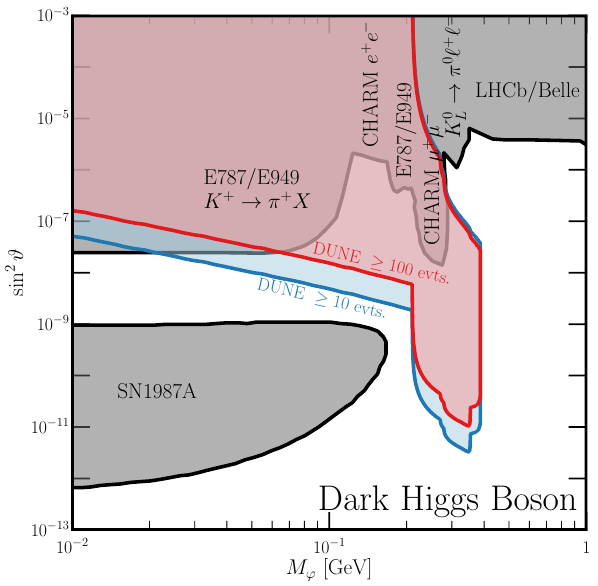
Figure 17 . Region of the dark Higgs mass M ’ versus mixing between the dark and SM Higgs bosons sin 2 # parameter space where one expects more than 10 (100) dark Higgs scalar decays in the DUNE MPD, in blue (red). In grey is the region of parameter space currently experimentally